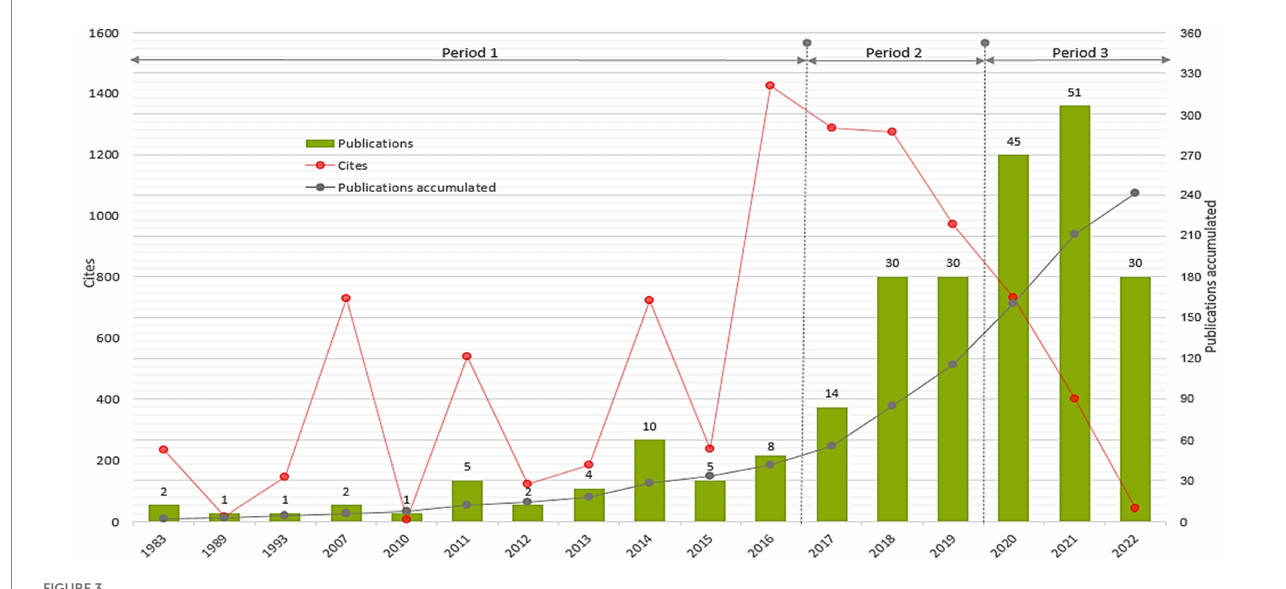
FIGURE 3 Distribution of publications and citations by year (1983–2022).